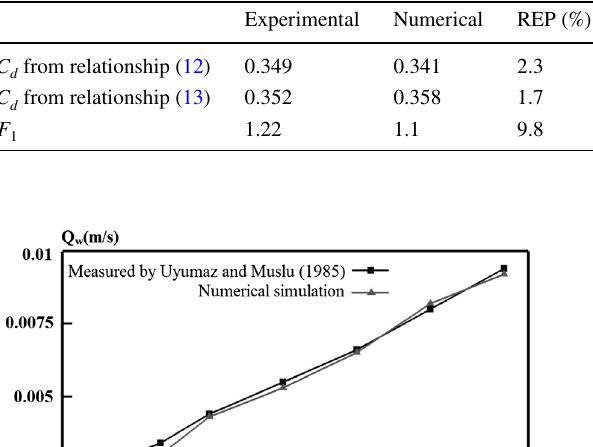
Table 3 Comparison of experimental and numerical Froude number and discharge coefficient Experimental